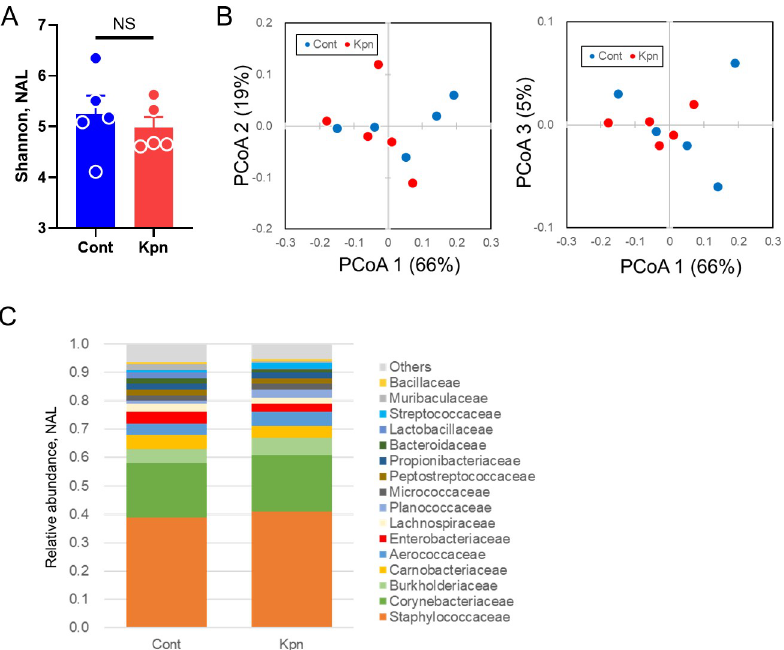
Fig 2. Nasal microbiota after K . pneumoniae infection. (A) Shannon index of nasal airway lavage (NAL) fluid. (B) Weighted UniFrac with three principal coordinate components. The number in parenthesis represents the contribution of each component. (C) Taxonomic distribution at the family level. Only families with 0.1% or more abundance in at least one group are presented. Data represent two independent experiments. Five mice were used for each group. Filled circles represent individual mice, and each bar represents the mean ± SEM. PCoA, principal coordinate analysis. NS, not significant.